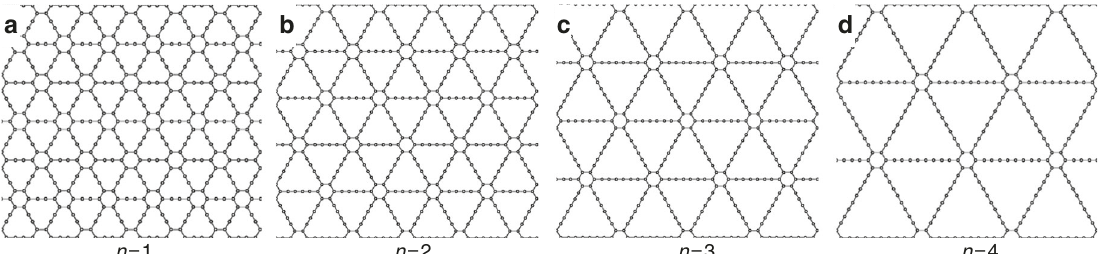
Fig. 1 Geometries of two-dimensional graphyne. a n = 1 corresponds to a side length of 0.69 nm. b n = 2 corresponds to a side length of 0.95 nm. c n = 3 corresponds to a side length of 1.20 nm. d n = 4 corresponds to a side length of 1.45 nm